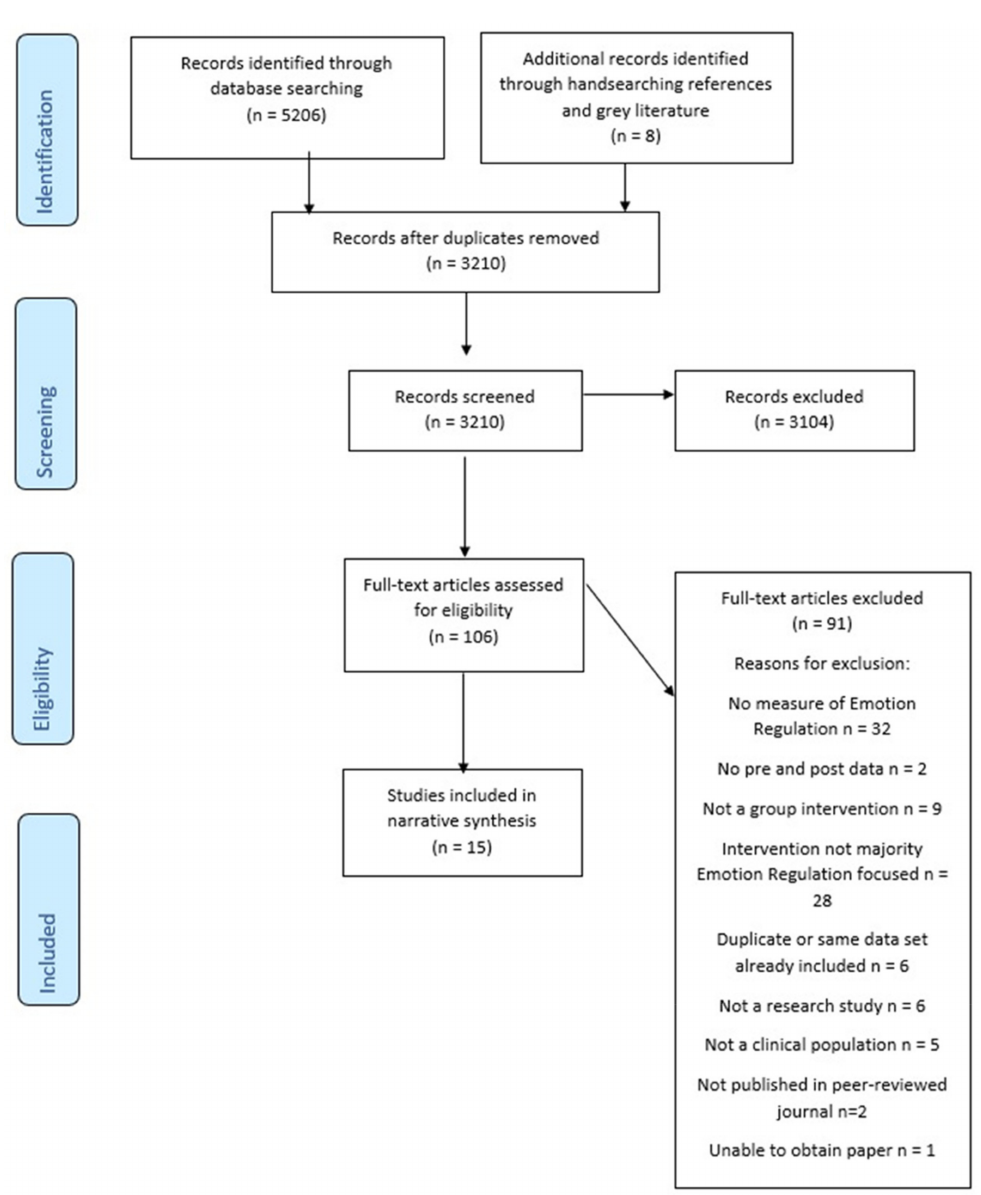
Figure 1. PRISMA 2009 Flow Diagram